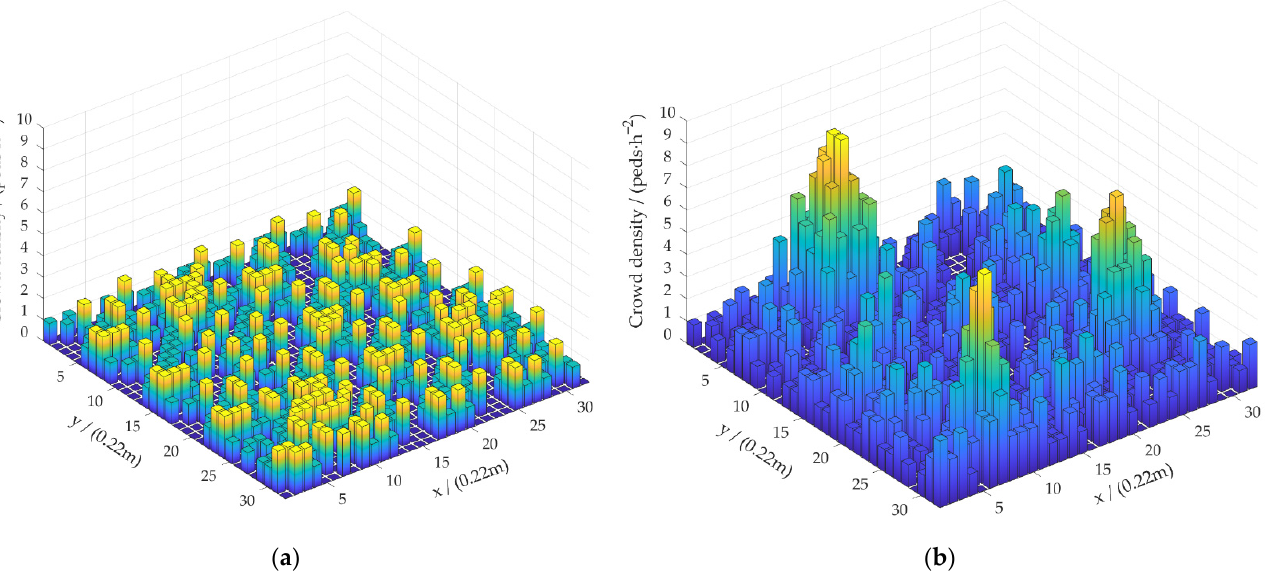
Figure 15. Visualizations of crowd density distribution detection results. ( a ) Initial crowd density distribution M old . ( b ) Final crowd density distribution M new